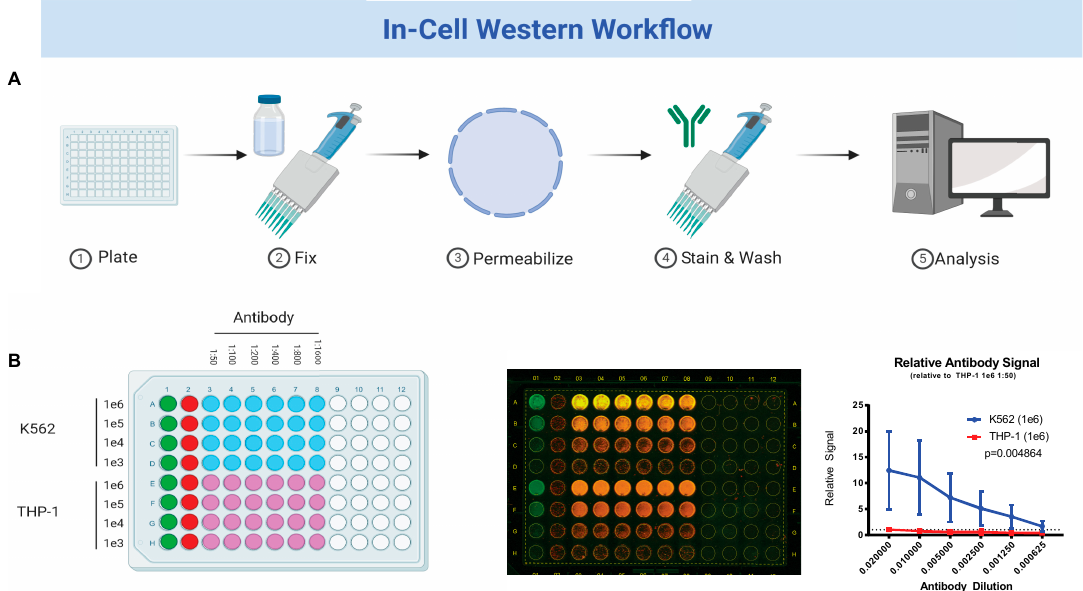
Figure 1. Validation of fetal hemoglobin antibody for in-cell Western workflow. ( A ) Workflow procedure for performing in-cell Western experiment. Further details are available in methods section; ( B ) antibody validation for fetal hemoglobin (HbF) in positive expression cell line (K562) normalized to negative expression cell line (THP-1).